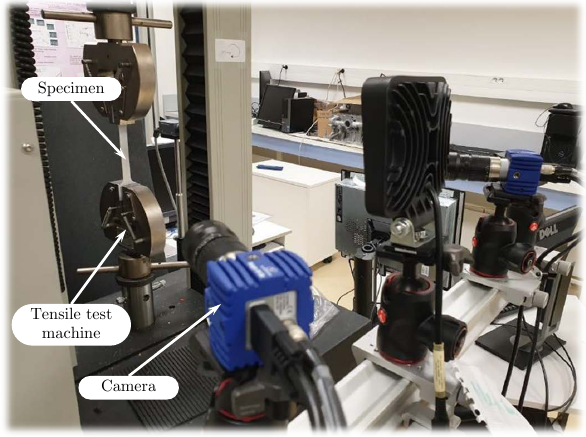
Figure 2. Experimental setup.